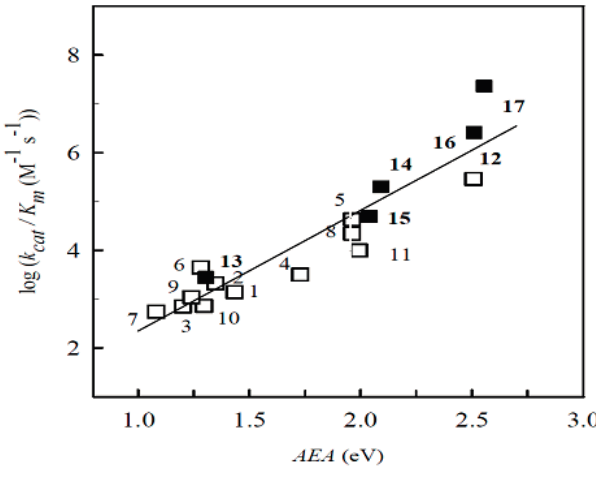
Figure 3. The dependence of reactivity expressed as log of the apparent second-order rate constants (k cat /K m ) of reduction of BFXs (Compounds 1–12, open squares) and NACs (Compounds 13–17, black squares) by NADPH:cytochrome P-450 reductase (P-450R) upon their adiabatic electron affinity (AEA), calculated by using B3LYP/6-311+G(d,p)